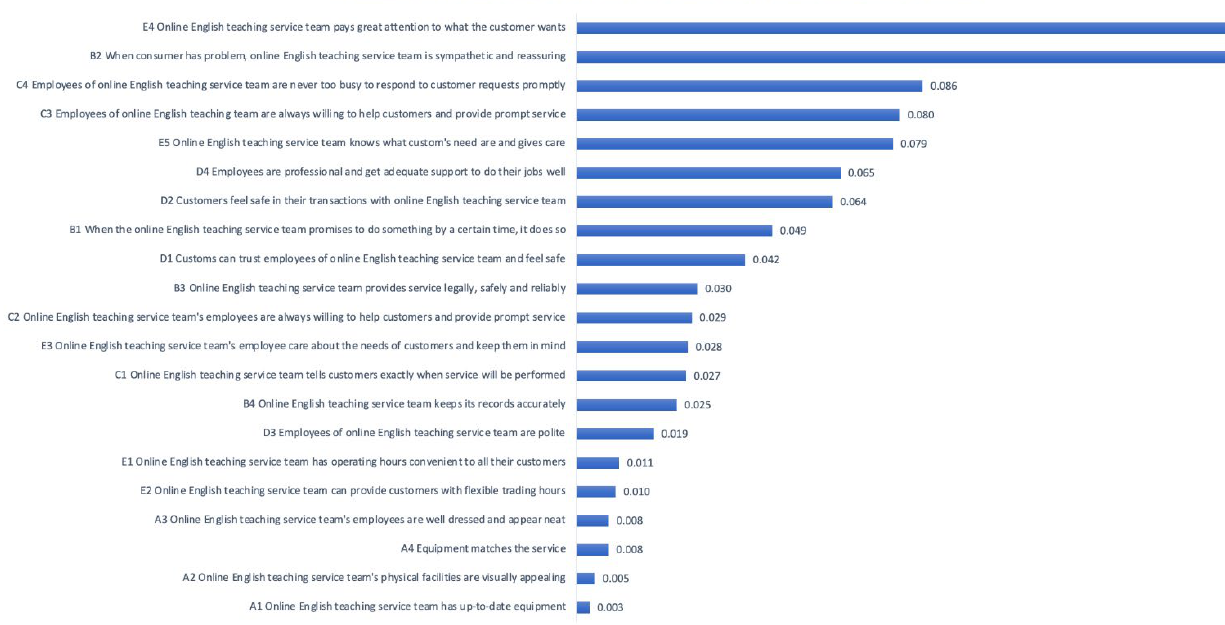
Figure 4. Indicators that were ordered by weight from the opinion of service providers.